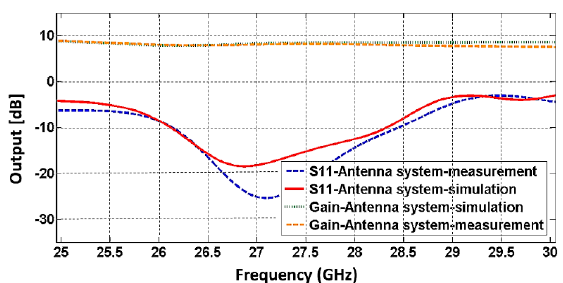
Figure 9. A regular coaxial connector is modeled in the simulation while in the measurement, an end launch connector has been used which causes the slight discrepancy between measurement and simulation. The radiation efficiency is calculated as a ratio between total co-polarized radiated power by the system to the input power accepted by the circuit. This parameter shows how efficient the system is in radiating or receiving the signal. The radiation efficiency for this system is 91.3% and 90.7% at 27 GHz and 28 GHz, respectively.